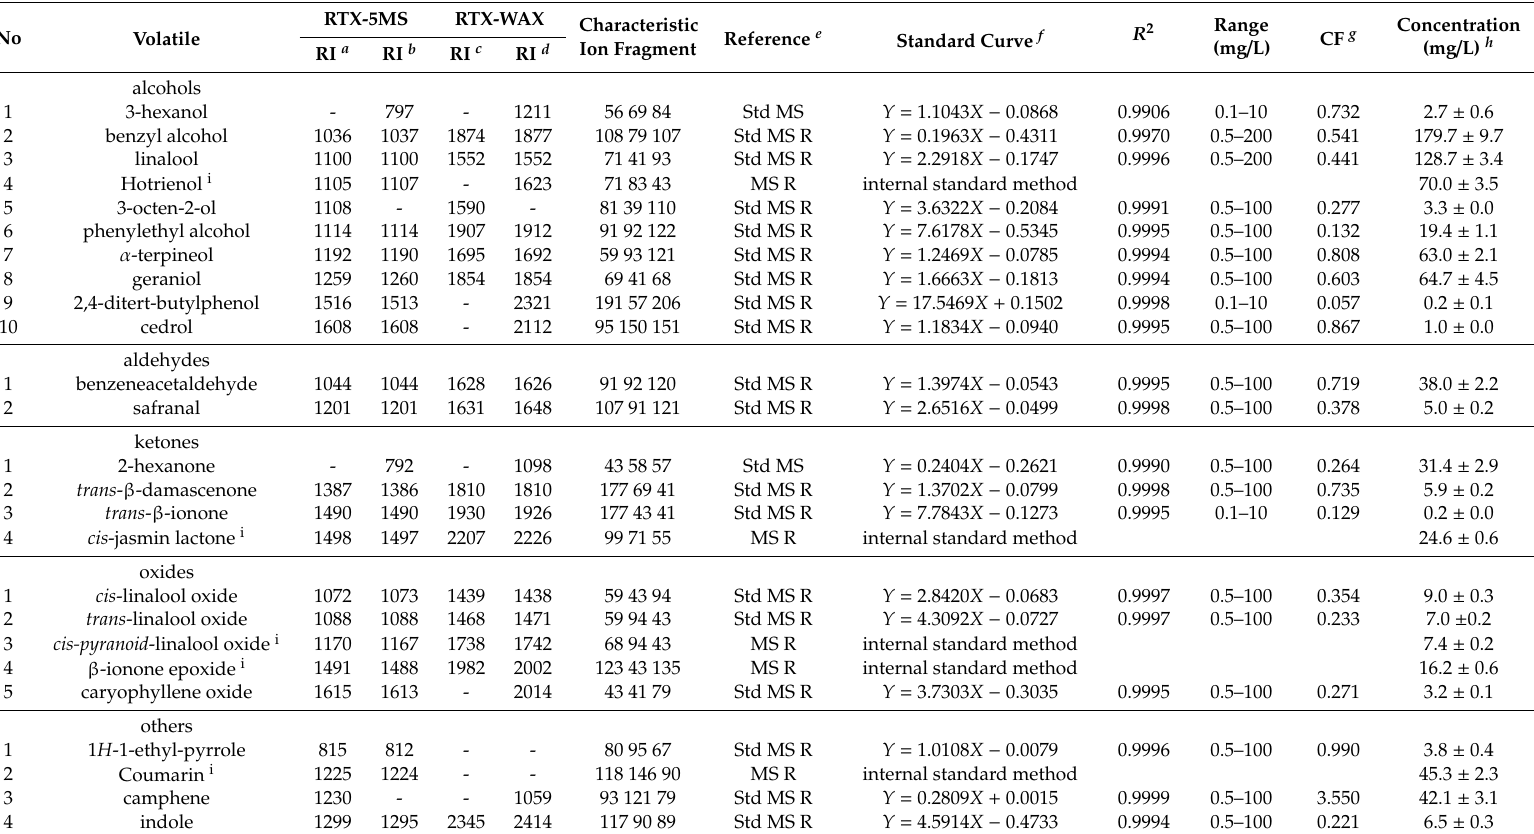
Table 1. Qualitative and quantitative analysis of volatile compounds in the SDE